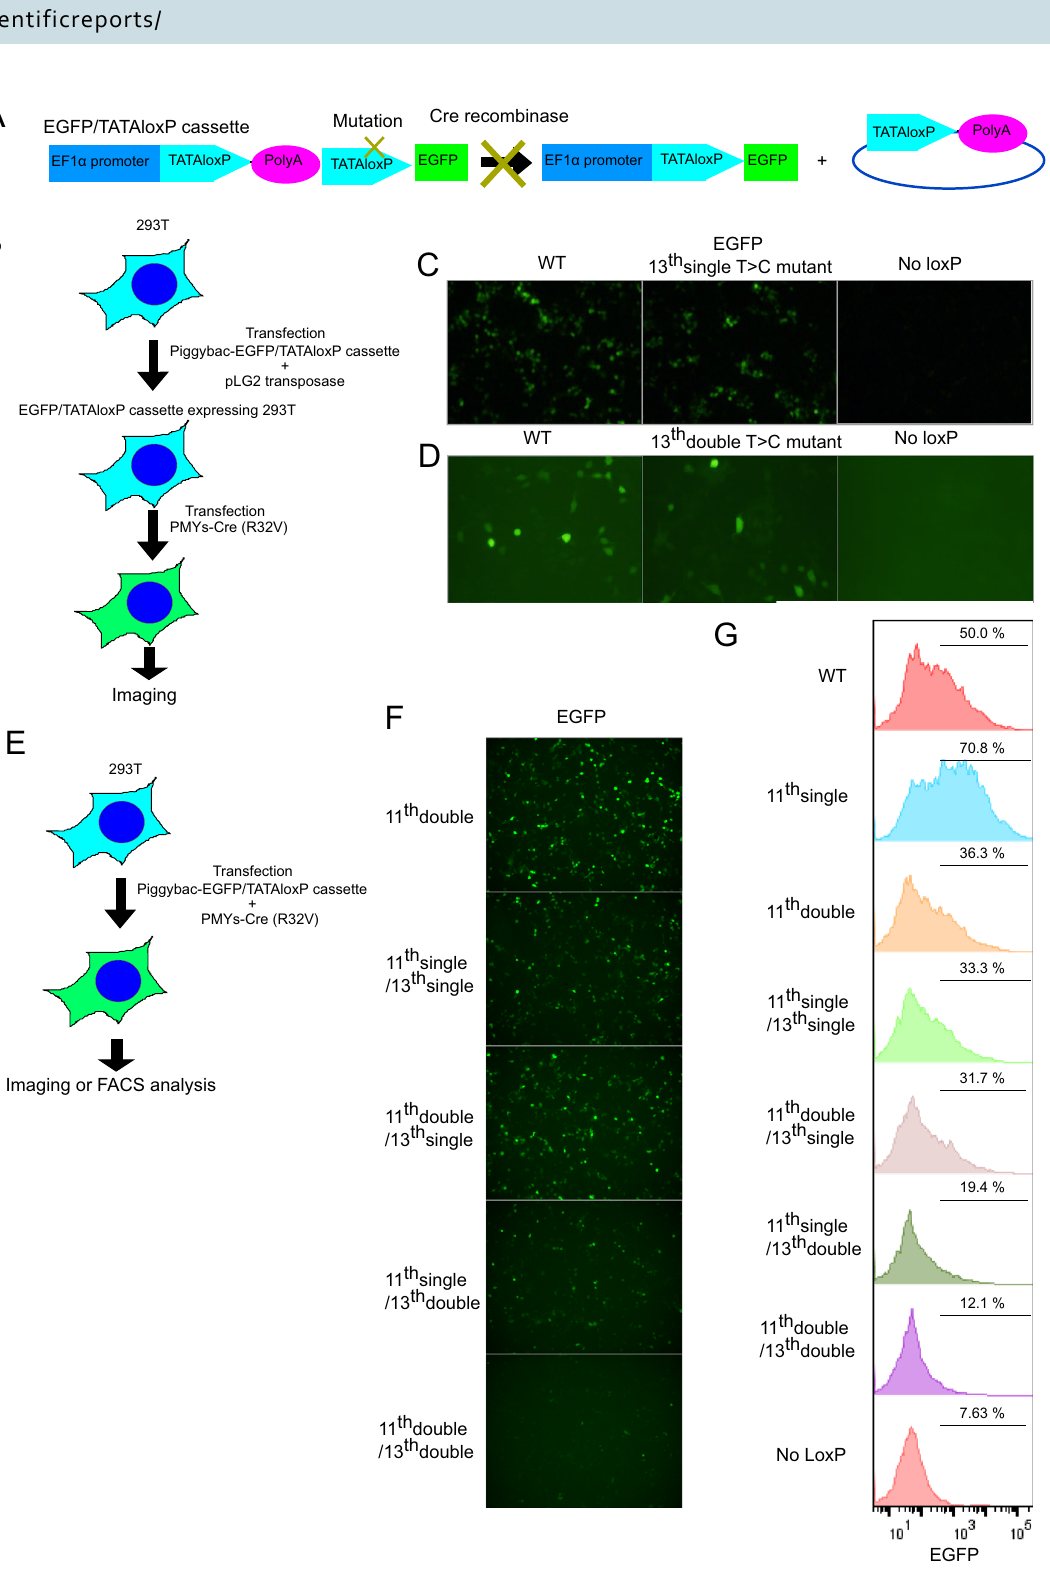
Figure 6. Screening of non-responsive TATAloxP with T > C mutations in mammalian cells. ( A ) Schematic representation of the EGFP cassette with mutated TATAloxP and polyA sequences under the EF1α promoter. ( B ) Experimental scheme used in ( C , D ). 293 T cells were transduced with the EGFP/TATAloxP cassette, and the mutant EGFP-expressing 293 T cells were subsequently transfected with Cre-R32V. ( C , D ) Fluorescence images of 293 T cells expressing EGFP/ various TATAloxP with the indicated T > C mutations and Cre-R32V. ( E ) Experimental scheme as in ( F , G ). 293 T cells were transfected with EGFP/TATAloxP cassette and Cre-R32V. ( F , G ) Fluorescence images ( F ) and FACS plots ( G ) of 293 T cells expressing EGFP/various TATAloxP with the indicated T > C mutations and Cre-R32V. WT; wild